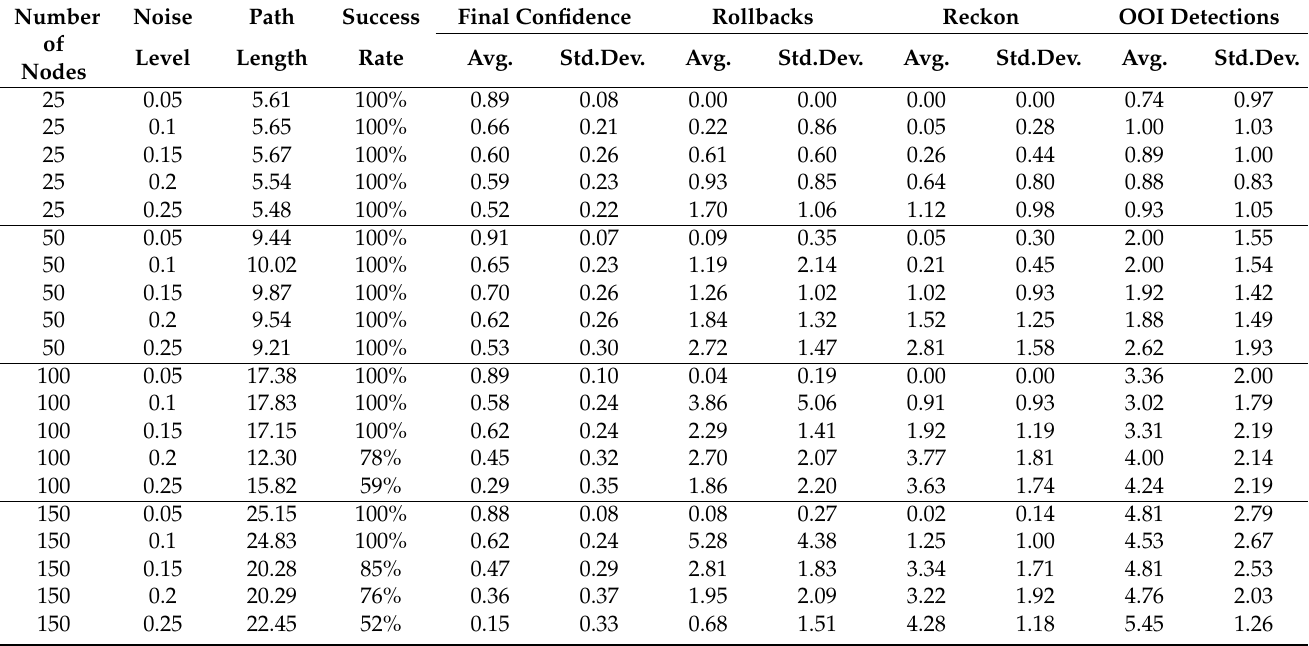
Table 4. Impact of OOI detection on navigation, for P (OOI) = 0.2 (approximately 20% of nodes that contain recognizable features), and P(detection) = 0.9.